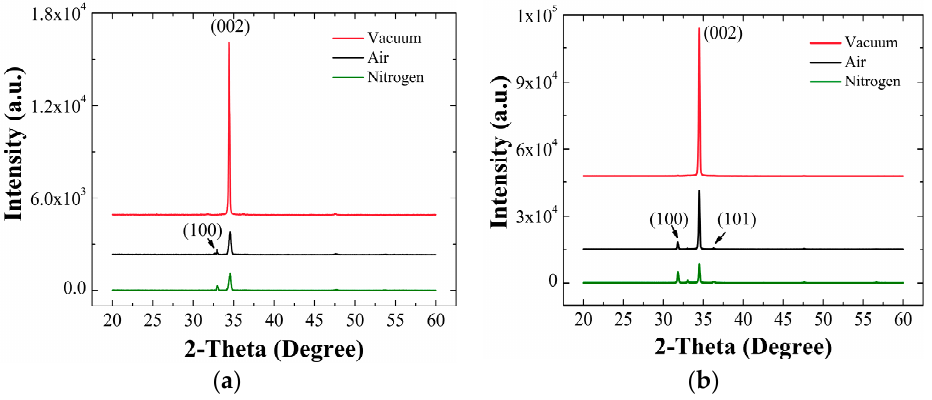
Figure 3. θ -2 θ X-ray diffraction (XRD) patterns of ( a ) the SLs annealed in three different ambients; and ( b ) the ZnO NR grown on each different SL.